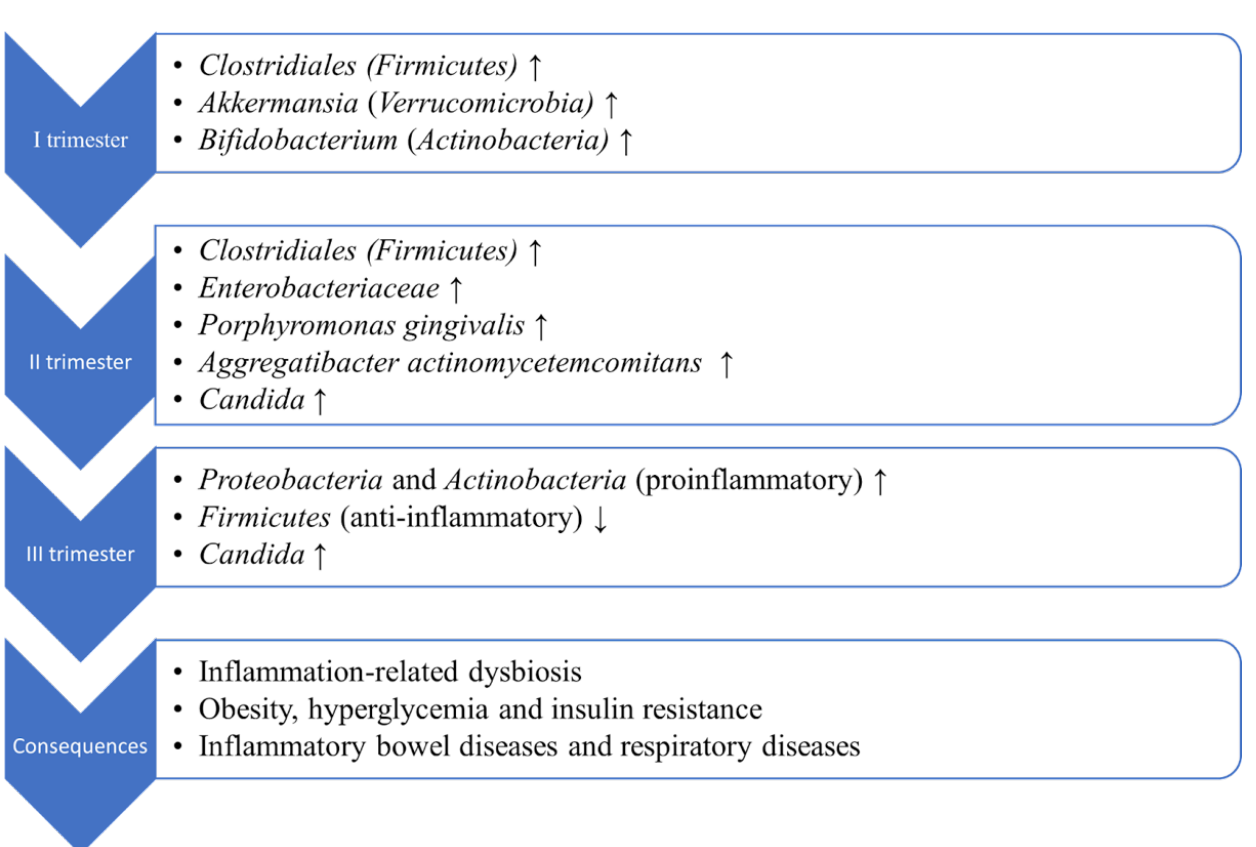
Figure 2. Evolution of the microbiota during pregnancy and its consequences. Table 2. Dietary influence in gut microbiota